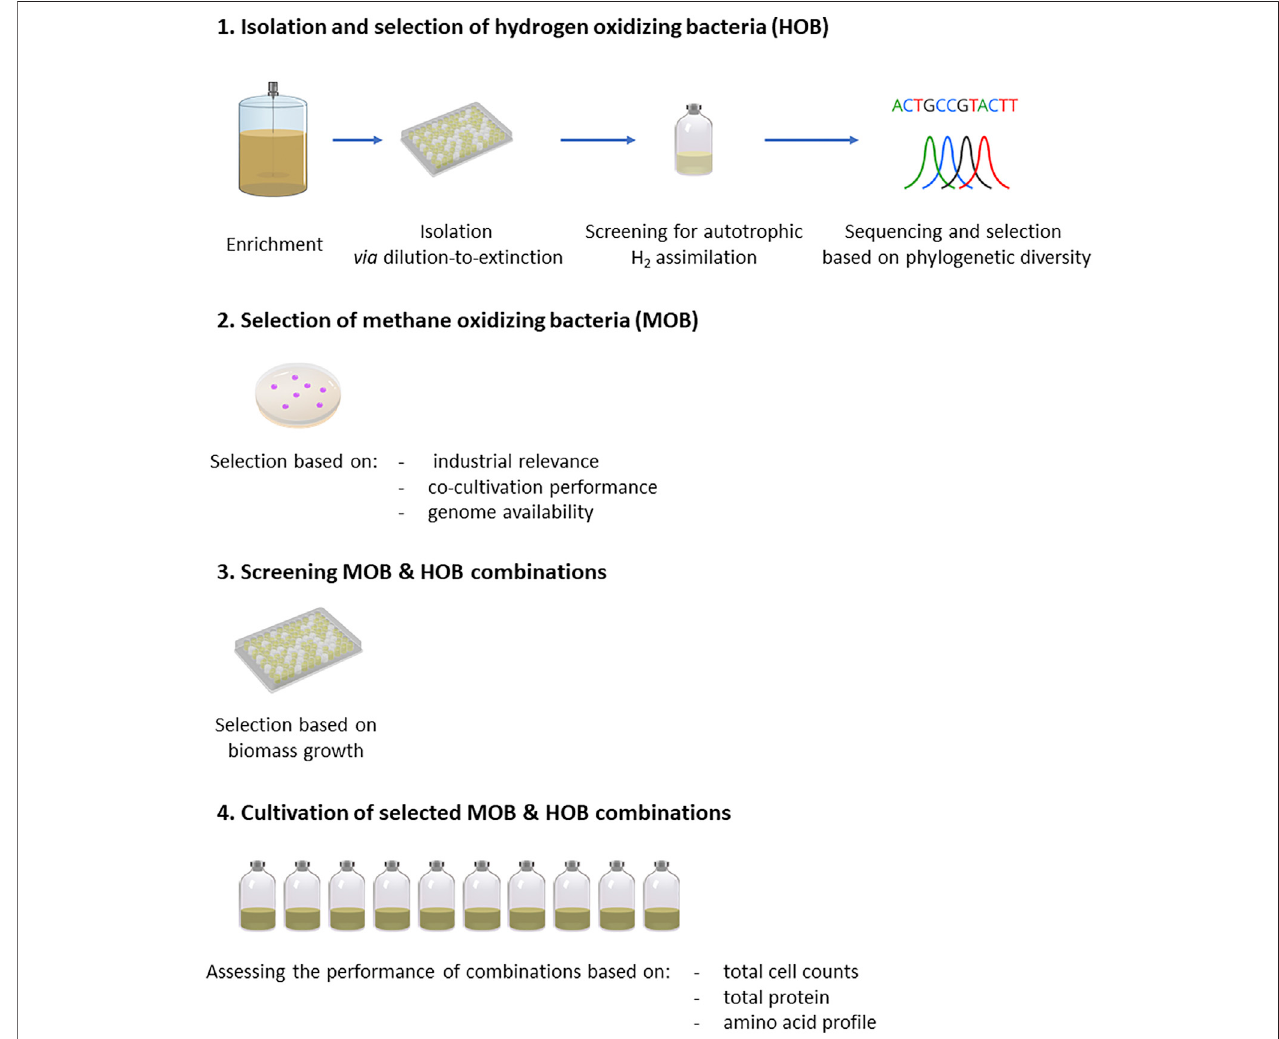
FIGURE 2 | Experimental methodology followed for the enrichment, selection, screening and assessment of pure cultures of HOB and MOB as well as their combination, in the context of microbial protein production.